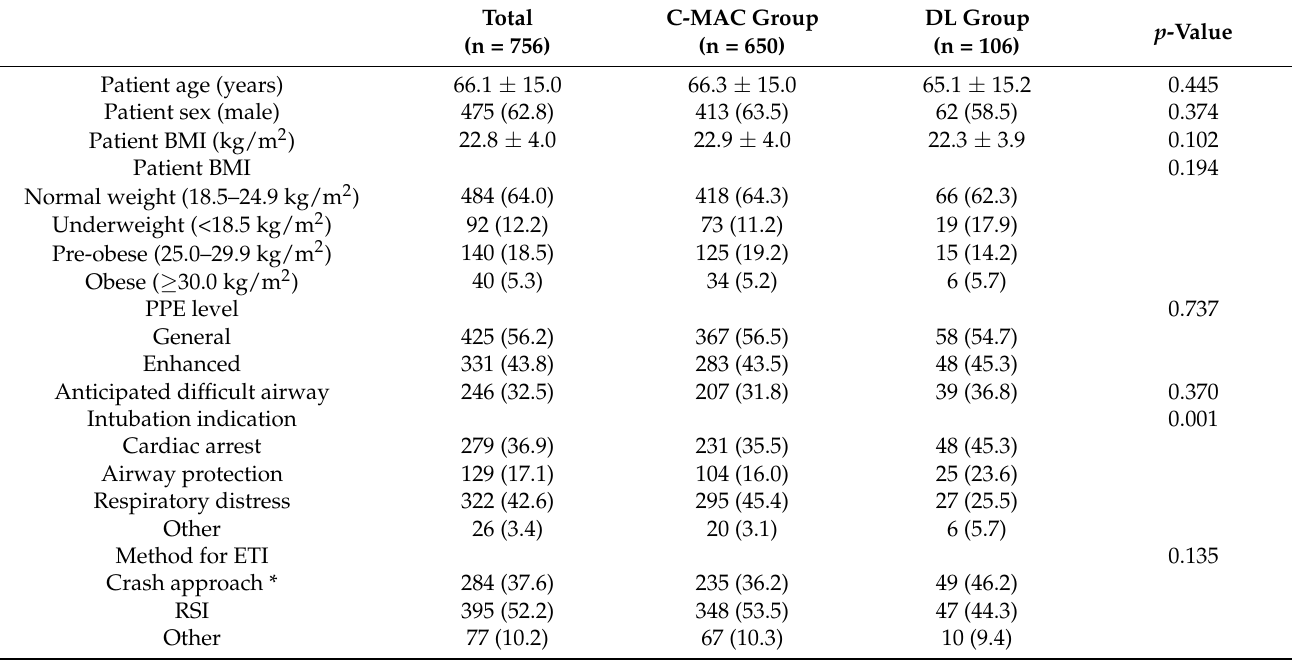
Figure 1. Study flowchart. ETI, endotracheal intubation; C-MAC, C-MAC video laryngoscope; DL, direct laryngoscope. Table 1. Baseline characteristics of patients and endotracheal intubation procedures.